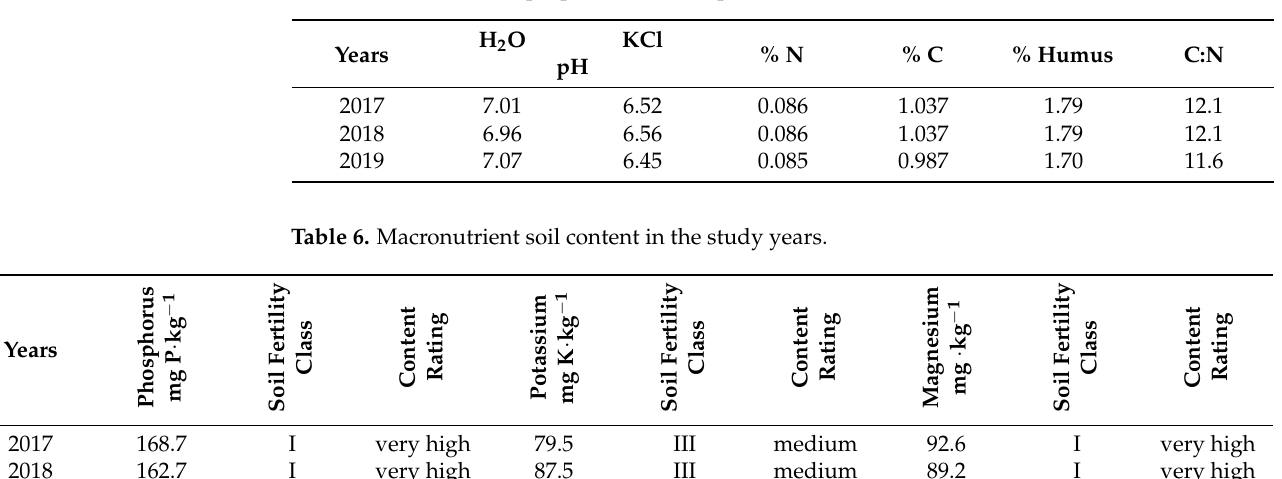
Table 5. Basic chemical properties of the experimental field soil.